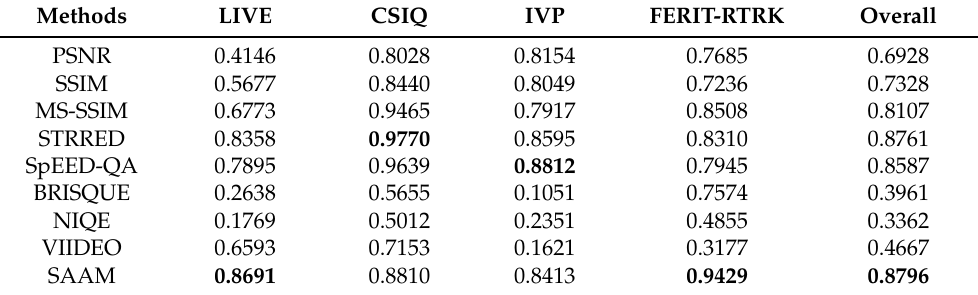
Table 3. Performance comparison in terms of SRCC.